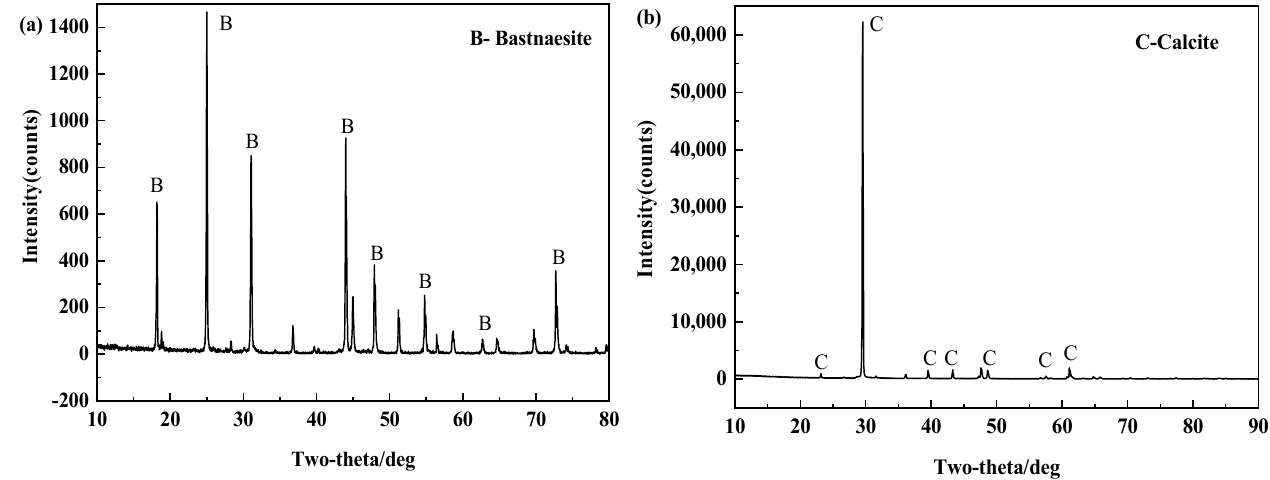
Figure 1. XRD patterns of bastnaesite ( a ) and calcite ( b ). Table 1. Elemental analysis results (%) of bastnaesite and calcite sample.